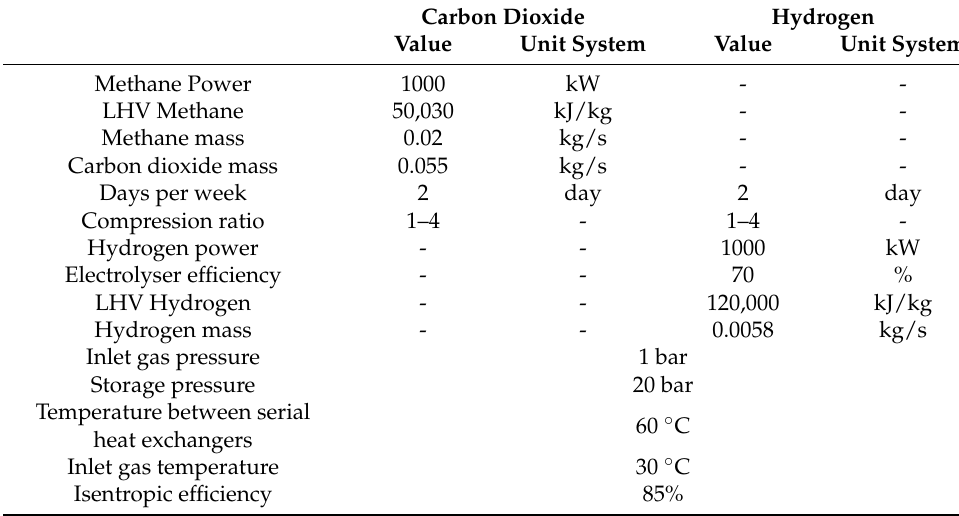
Table 1. Simulation hypothesis.